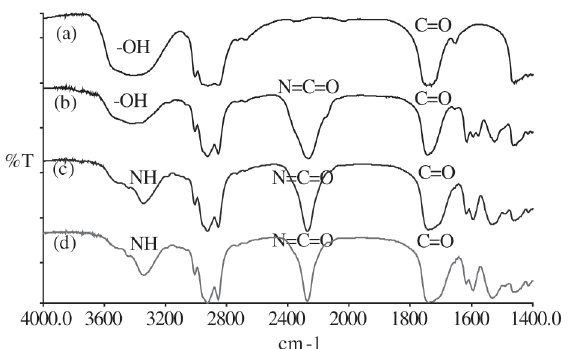
Figure 1. FTIR spectra of a) castor oil; b) castor oil polyurethane at zero; c) 30; d) 120 min of reaction.